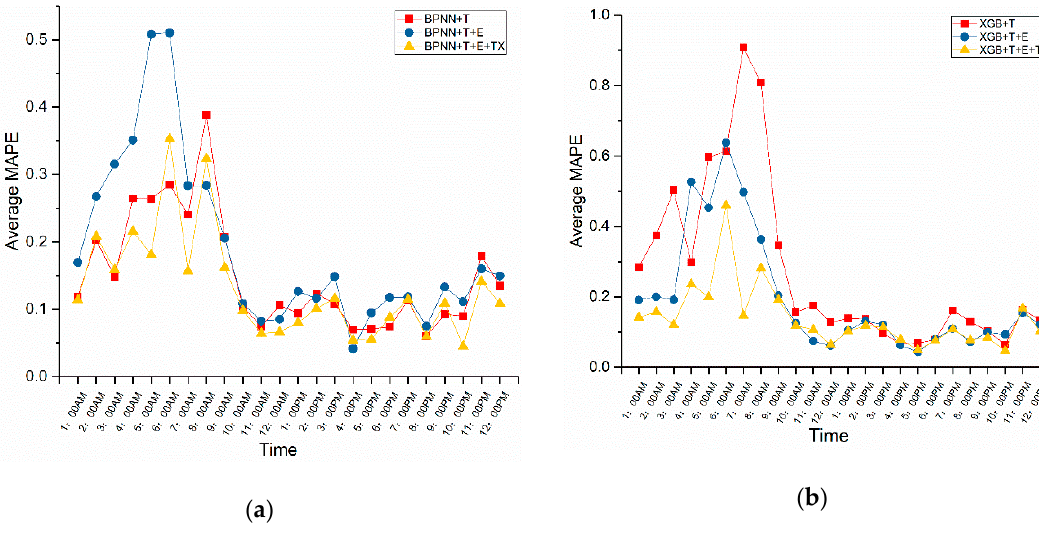
Figure 7. Average mean absolute percentage error (MAPE) of online taxi-hailing demand prediction based on BPNN and XGB in different hours. ( a ) MAPE of the prediction models based on BPNN; ( b ) MAPE of the prediction models based on XGB.